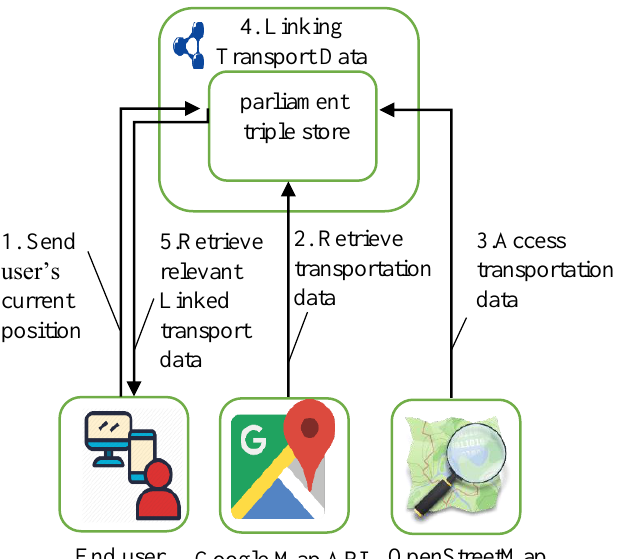
Figure 4. Overview of proposed